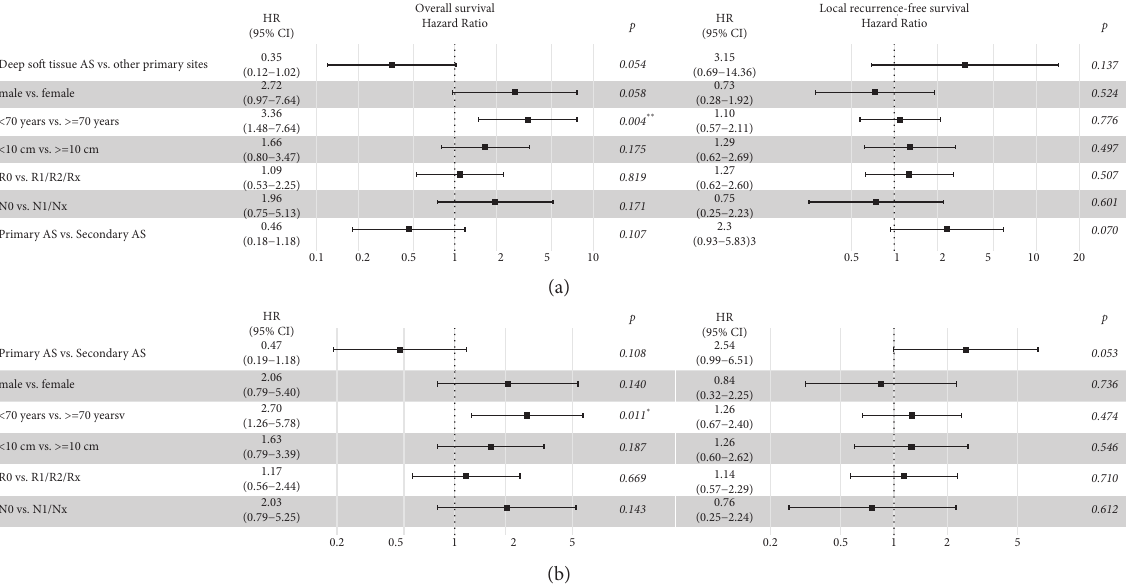
Figure 4: Multivariate analysis. Forest plots of multivariate Cox regression analysis on overall survival (left) and local recurrence-free survival (right) for the subgroups (a) deep soft tissue angiosarcomas and (b) primary vs. secondary angiosarcomas showing hazard ratio (HR), 95% confidence interval (CI), and p